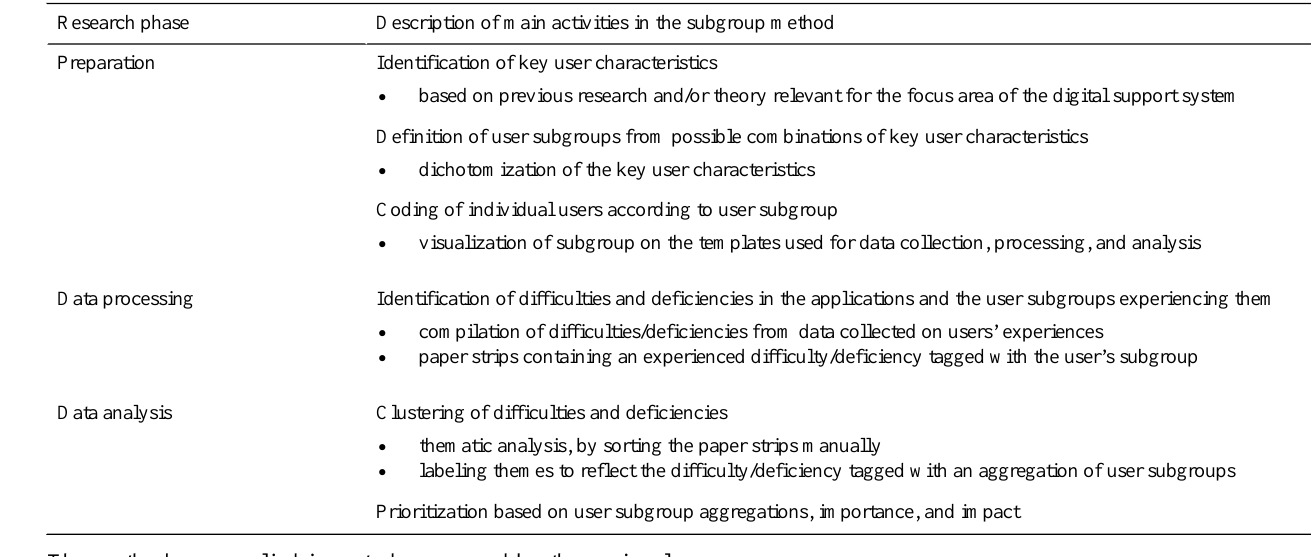
Table 3. Presentation of main activities in the method for identifying key user characteristics and systematic tracking of user subgroup feedback. Description of main activities in the subgroup methodResearch